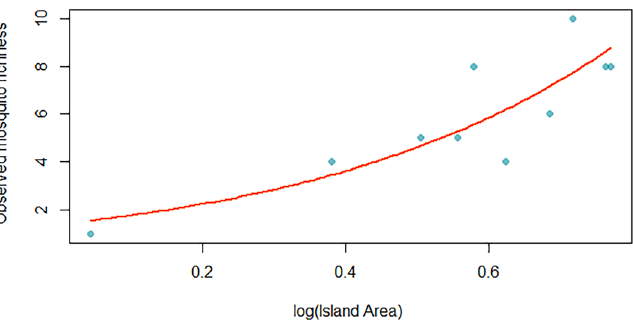
Figure 4. Species-area relationship between log area and mosquito richness found in the Lakshadweep